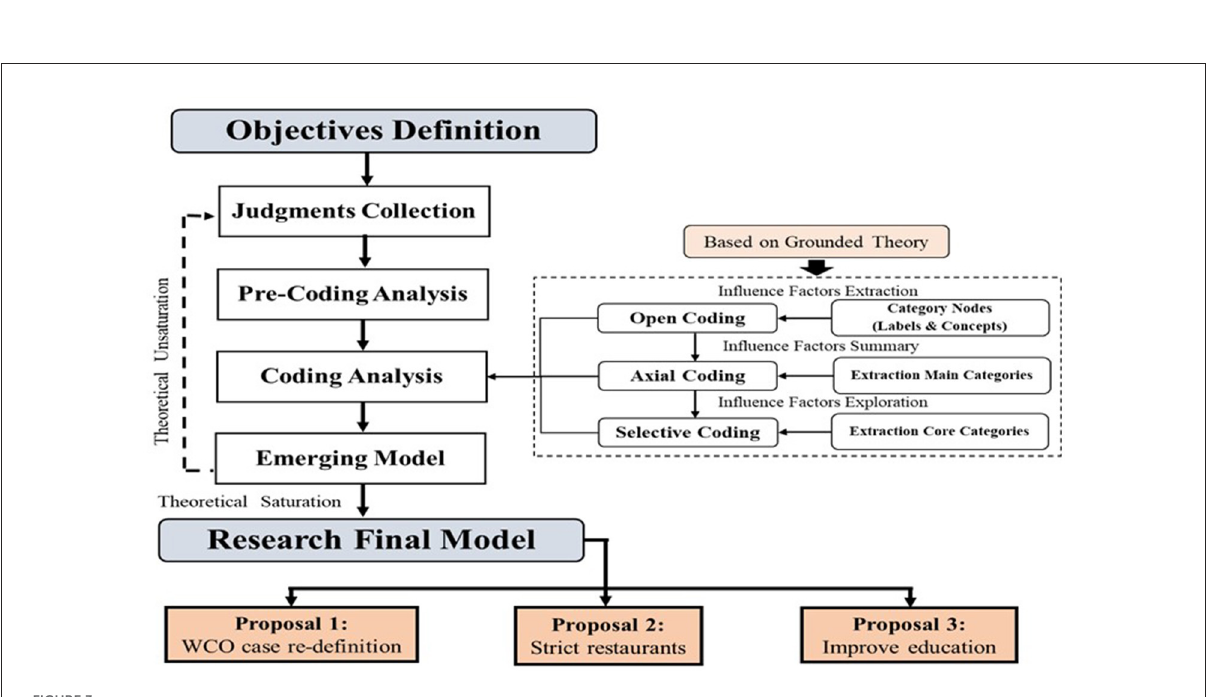
FIGURE3 Theoretical framework based on Chen et al.